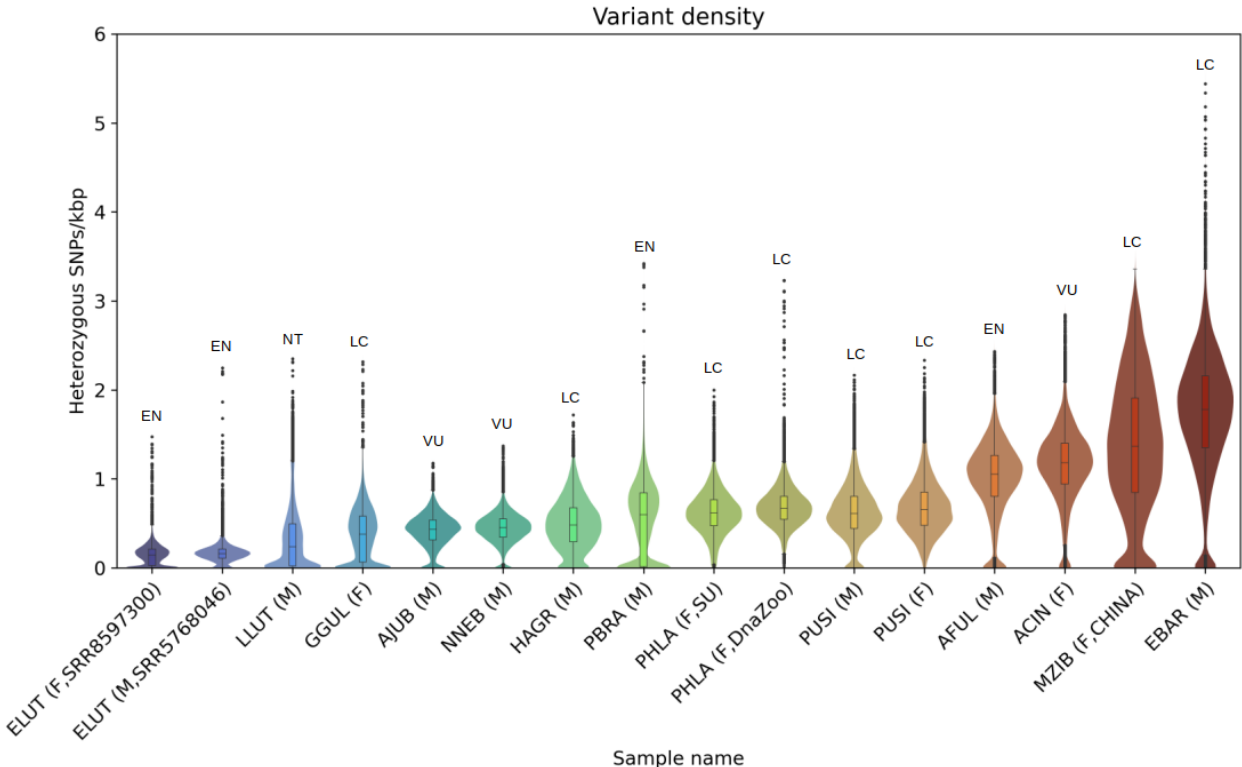
Figure 6. Violin and boxplots of heterozygosity distribution for analyzed samples of Felidae, Ailuridae, Mustelidae , and Phocidae species: Enhydra lutris (ELUT, EN), Lutra lutra (LLUT, NT), Gulo gulo (GGUL, LC), Acinonyx jubatus (AJUB, VU), Neofelis nebulosa (NNEB, VU), Halichoerus grypus (HAGR, LC), Pteronura brasiliensis (PBRA, EN), Phoca largha (PHLA, LC), Pusa sibirica (PUSI, LC), Ailurus fulgens (AFUL, EN), Aonyx cinereus (ACIN, VU), Martes zibellina (MZIB, LC), Erignathus barbatus (EBAR, LC). IUCN Red List categories: LC — least concern, NT — near threatened, VU — vulnerable, EN — endangered.